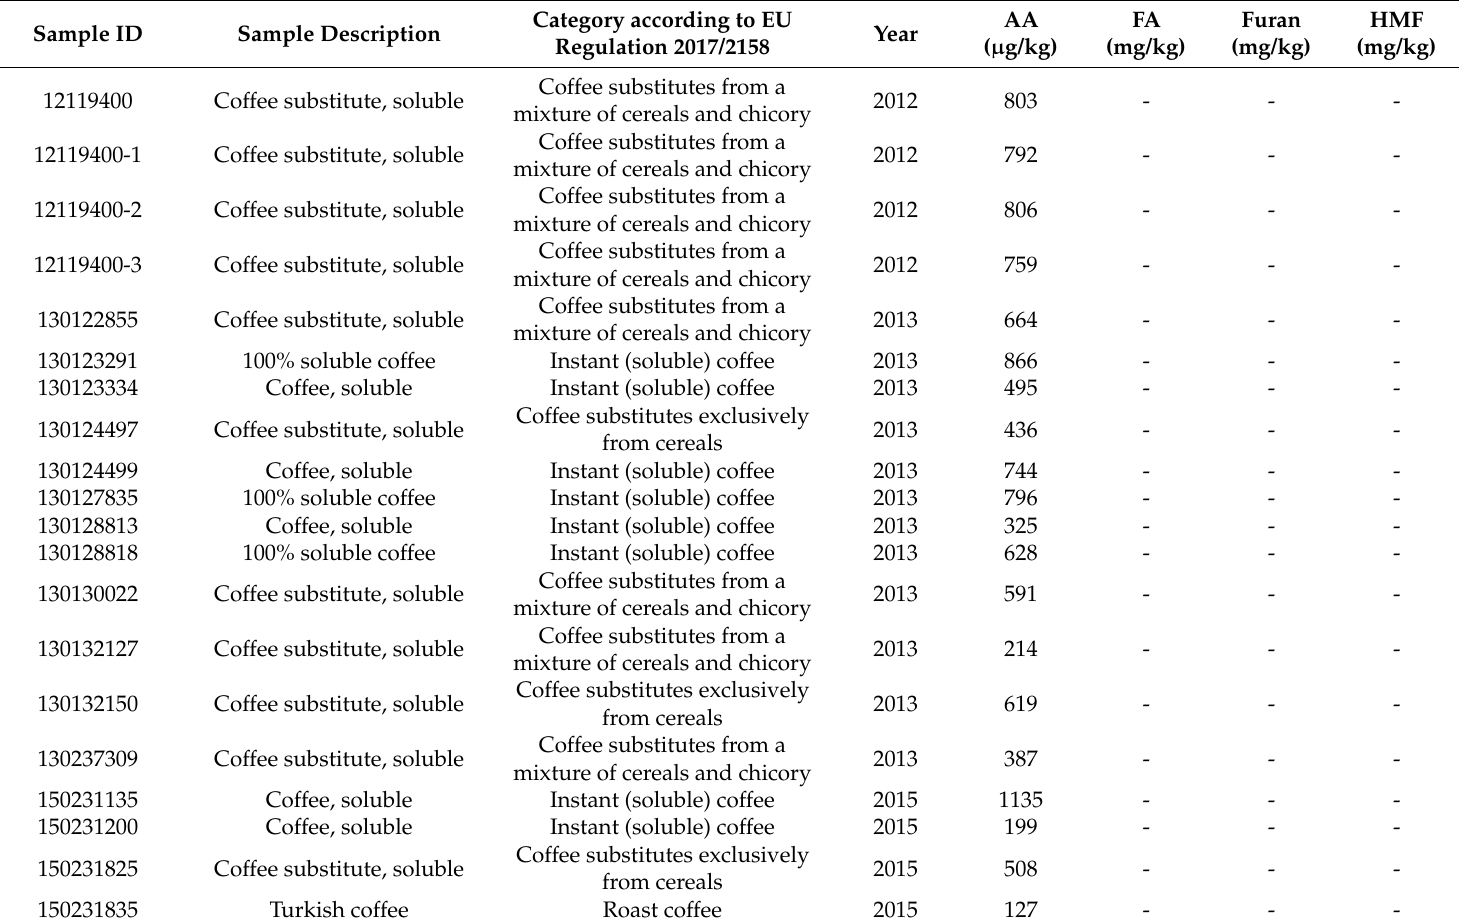
Table A1. Full analytical results of samples measured between 2012–2018 for acrylamide, furfuryl alcohol and